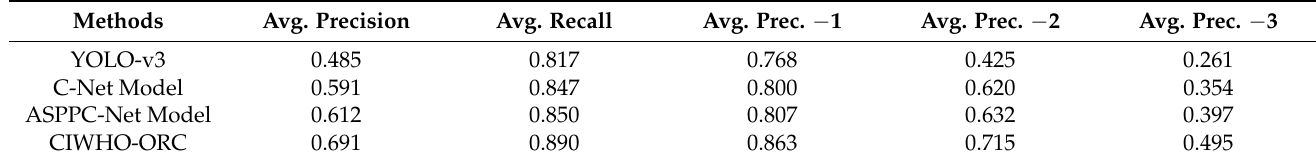
Table 3. APE and ARE Analysis of CIWHO-ORC technique on Bdd100k Dataset.